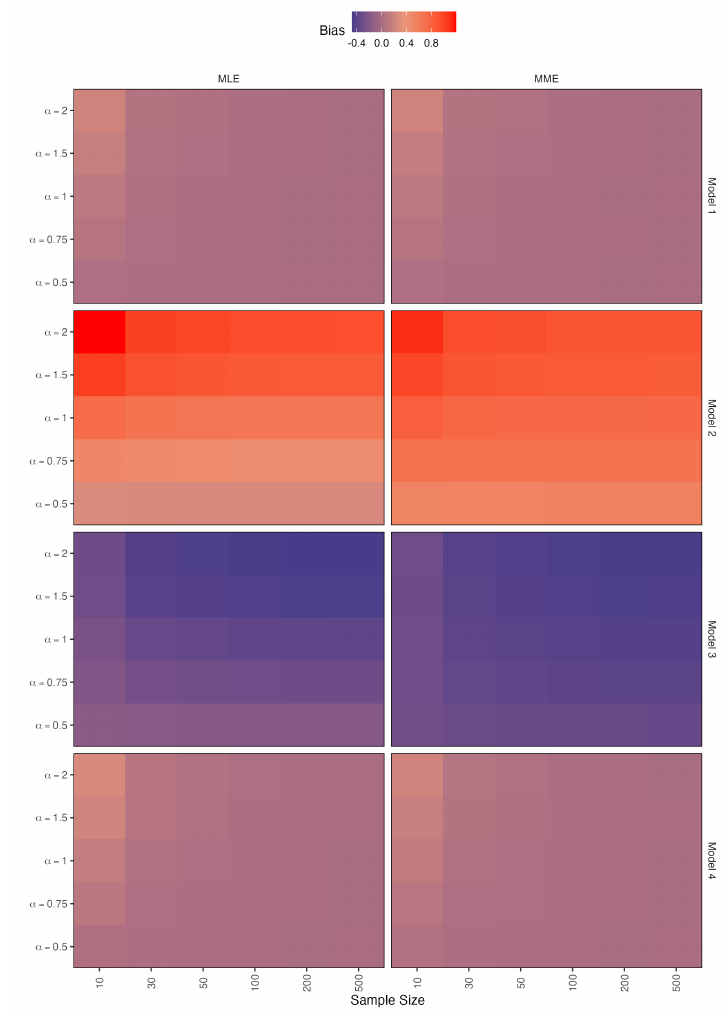
Figure 7. Simulated biases for the estimators of β